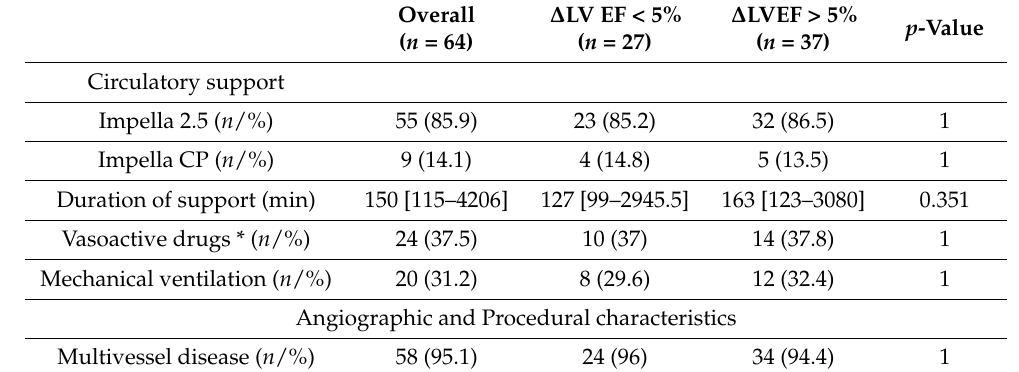
Table 2. Procedural and angiographic characteristics of the study